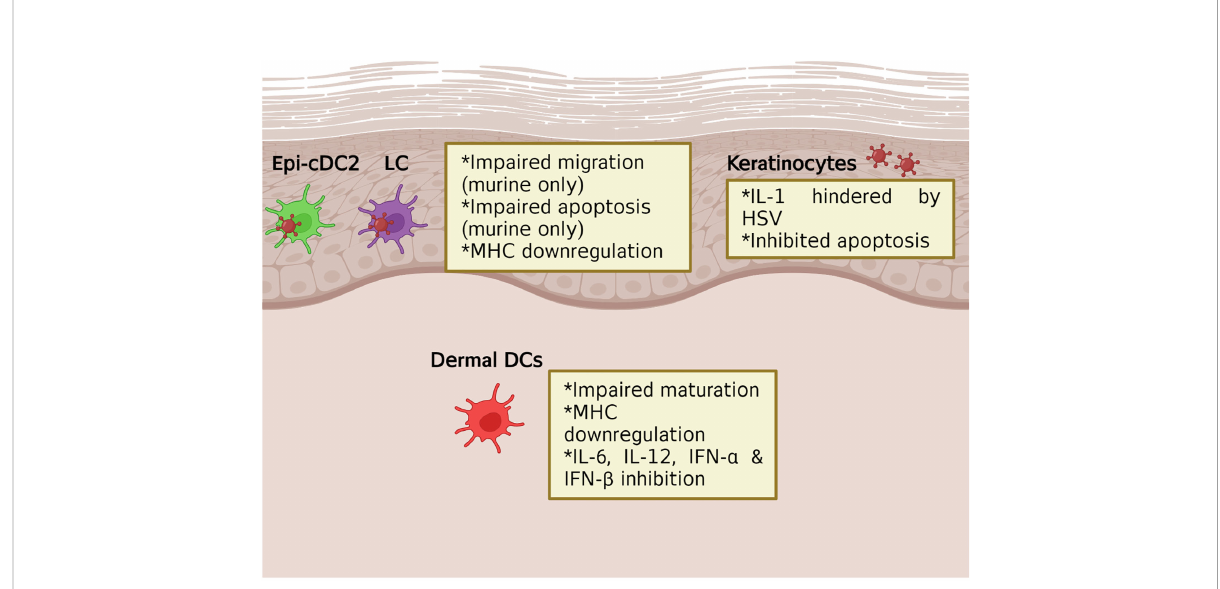
FIGURE 3 The impact of HSV on initial immune cells production of cytokines and chemokines. In murine models, HSV infection of the initial immune cells, such as LCs, has been shown to lead to impaired migration and apoptosis. This leads to downstream effects seen in dermal DCs where migration and cytokine and chemokine production is inhibited. HSV infection of keratinocytes has also been shown to inhibit apoptosis and the production of